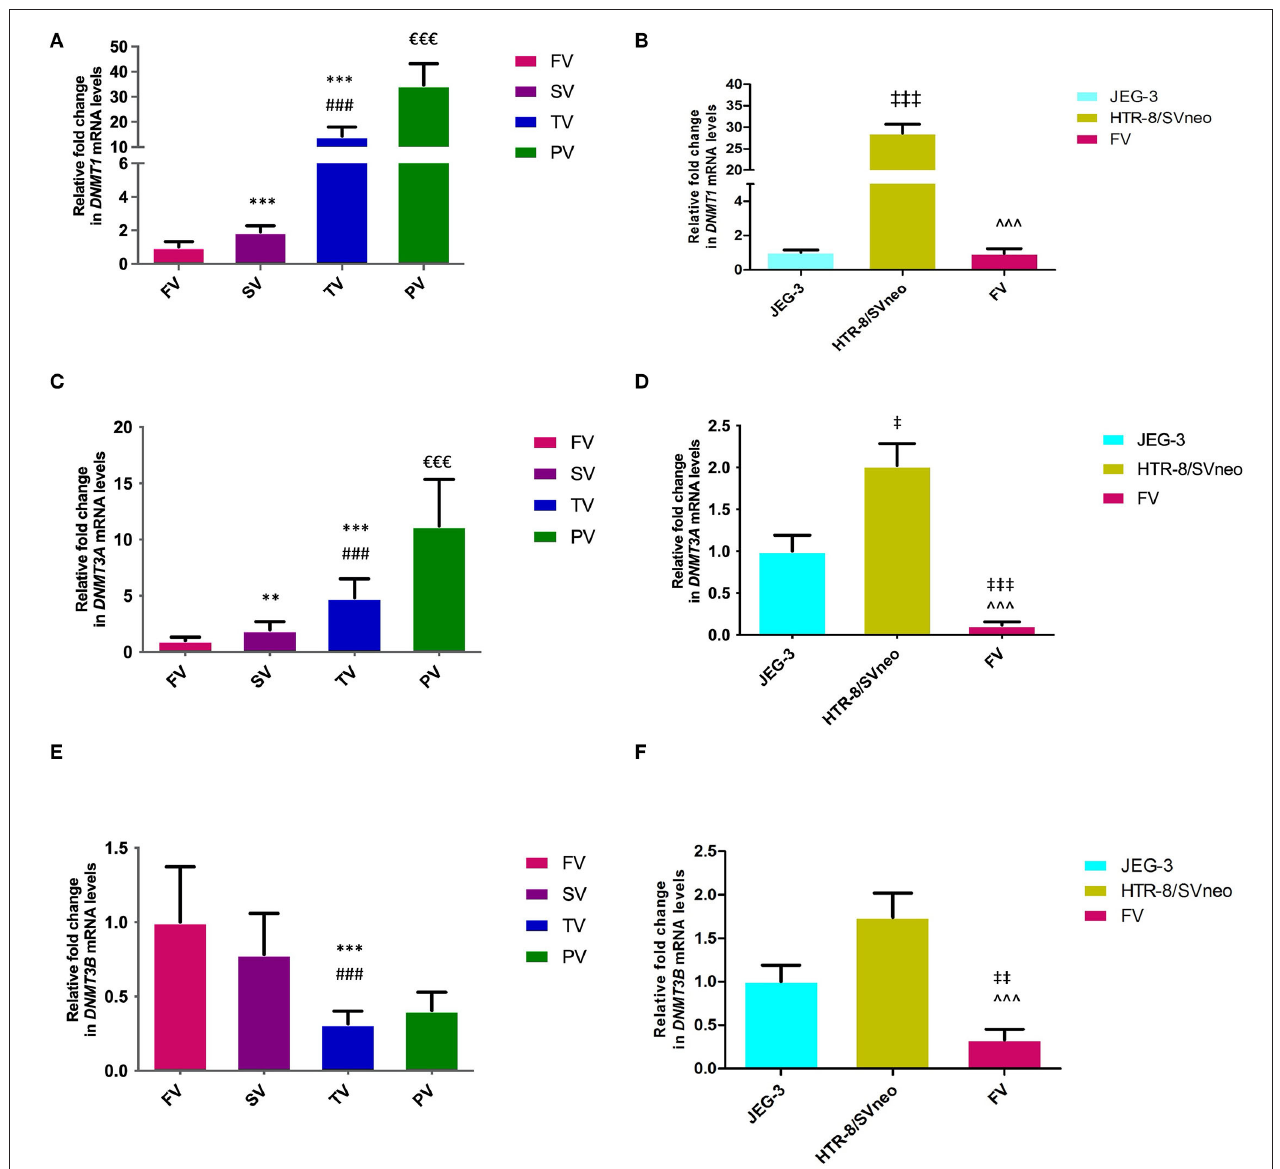
FIGURE 3 | qRT-PCR analysis of DNMTs normalized with GAPDH. (A, B) Relative fold change in DNMT1 mRNA levels, (C, D) relative fold change in DNMT3A mRNA levels (E, F) relative fold change in DNMT3B mRNA levels (A, C, E) among different villi samples (B, D, F) among different placental cells viz JEG-3, HTR-8/Svneo and first trimester villi. The data are expressed as mean fold change ± SEM. FV, SV, TV, and PV -first trimester, second trimester, third trimester, and preeclampsia placental villi samples respectively. [** p < 0.01, *** p < 0.001 with respect to FV, ### p < 0.001 with respect to SV, €€€ p < 0.001 with respect to TV], [ ‡ p < 0.05, ‡‡ p < 0.01, ‡‡‡ p < 0.001 with respect to JEG-3 and ∧∧∧ p < 0.001 with respect to